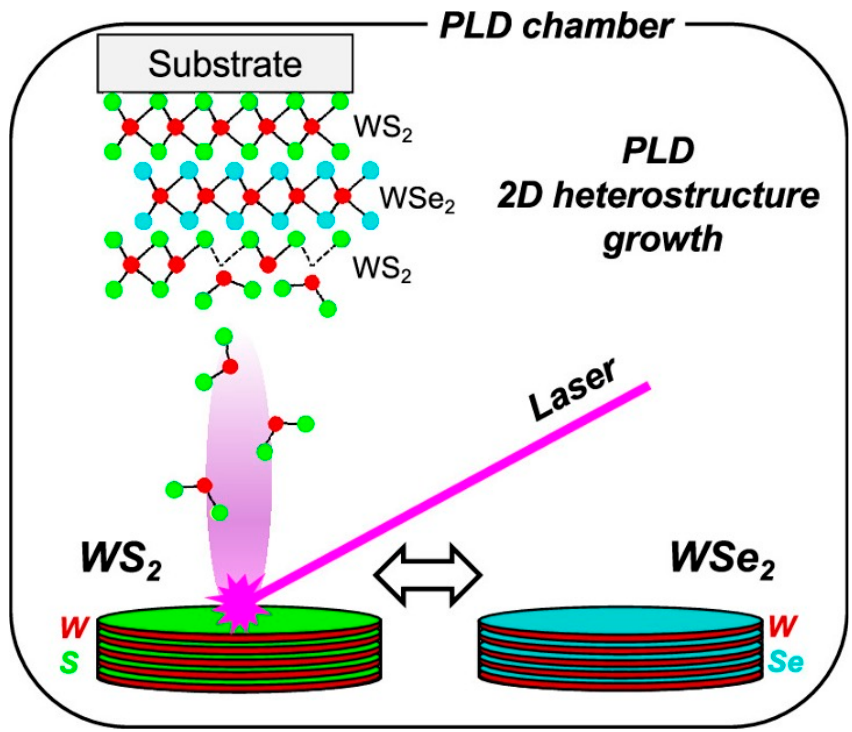
Figure 4. Schematic of PLD method for 2D vdWH. Adapted with permission from [64]. Copyright © 2021 The Authors.